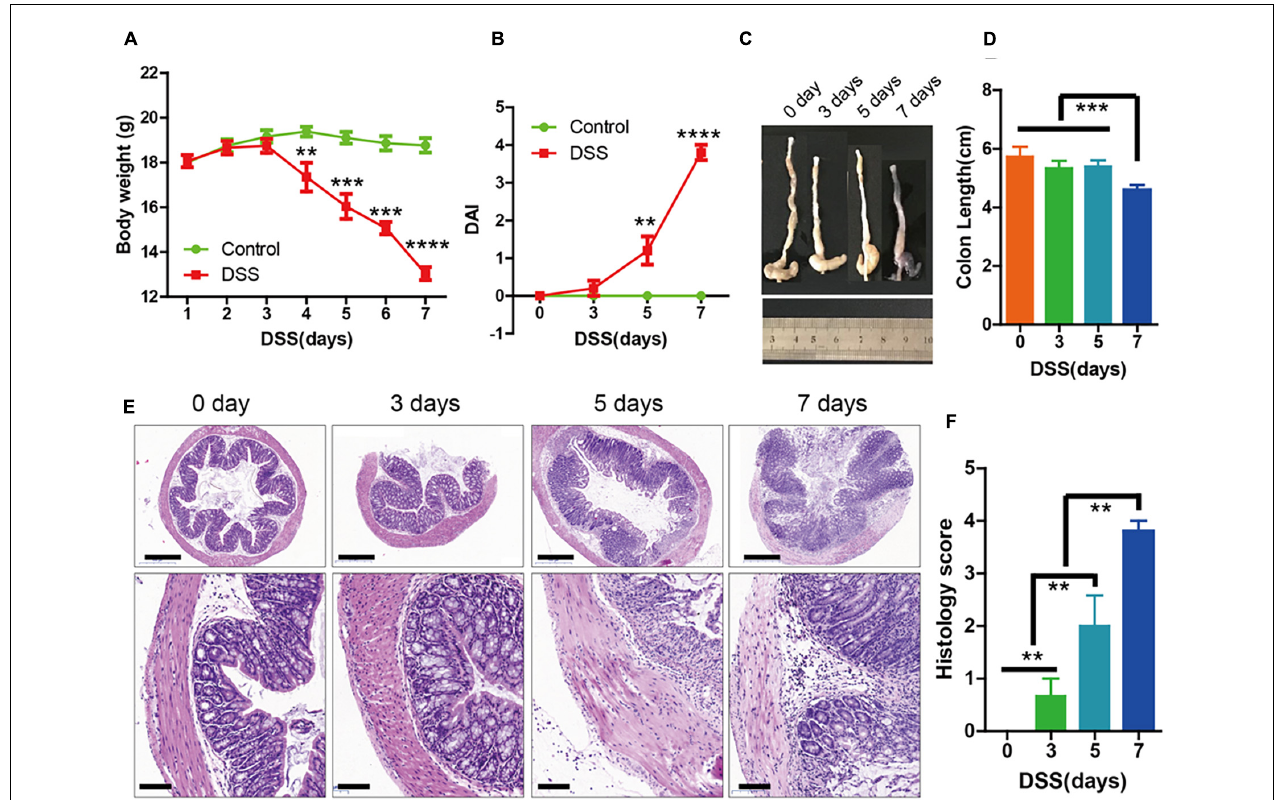
FIGURE 1 | The symptoms of dextran sulfate sodium (DSS)-induced colitis were significantly increased at 3 days. (A) Body weight in the control group and DSS-induced group ( n = 10 per group) for 0 to 7 days. (B) Disease activity index (DAI) of each group ( n = 10) for 0, 3, 5, and 7 days. (C,D) Colon lengths ( n = 10). (E) Sections of colon tissues stained with hematoxylin and eosin (H&E) and (F) histology scores from the two groups. Data represent mean ± SD with three independent experiments. One-way ANOVA and Bonferroni tests for multiple testing were applied in all cases. ** p < 0.01, *** p < 0.001, **** p < 0.0001. Scale bar = 500 and 100 µ